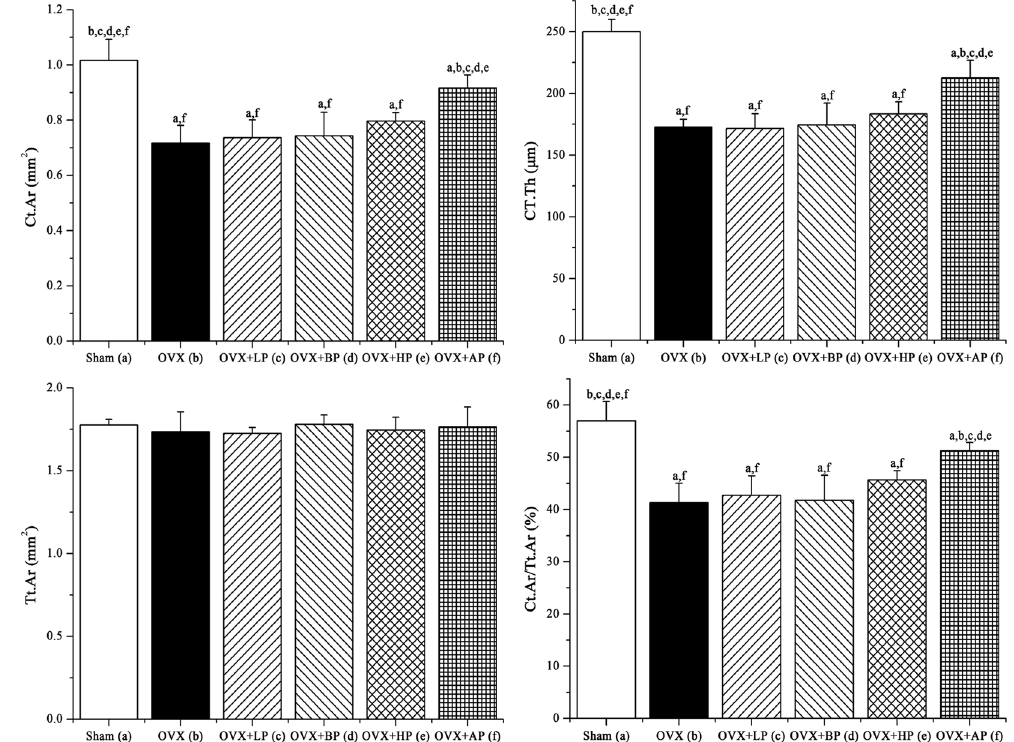
Figure 8. Effects of 8-week EMF exposure on cortical indices in the mid-diaphysis of the femur in OVX mice. Statistical comparisons of indices of trabecular bone microarchitecture. Values represent mean ± SD of 8/group. Letters a-f indicate differences between respective groups at P < 0.05 or * P < 0.01 (a versus Sham; b versus OVX; c versus OVX + LP; d versus OVX + BP; e versus OVX + HP; f versus OVX +